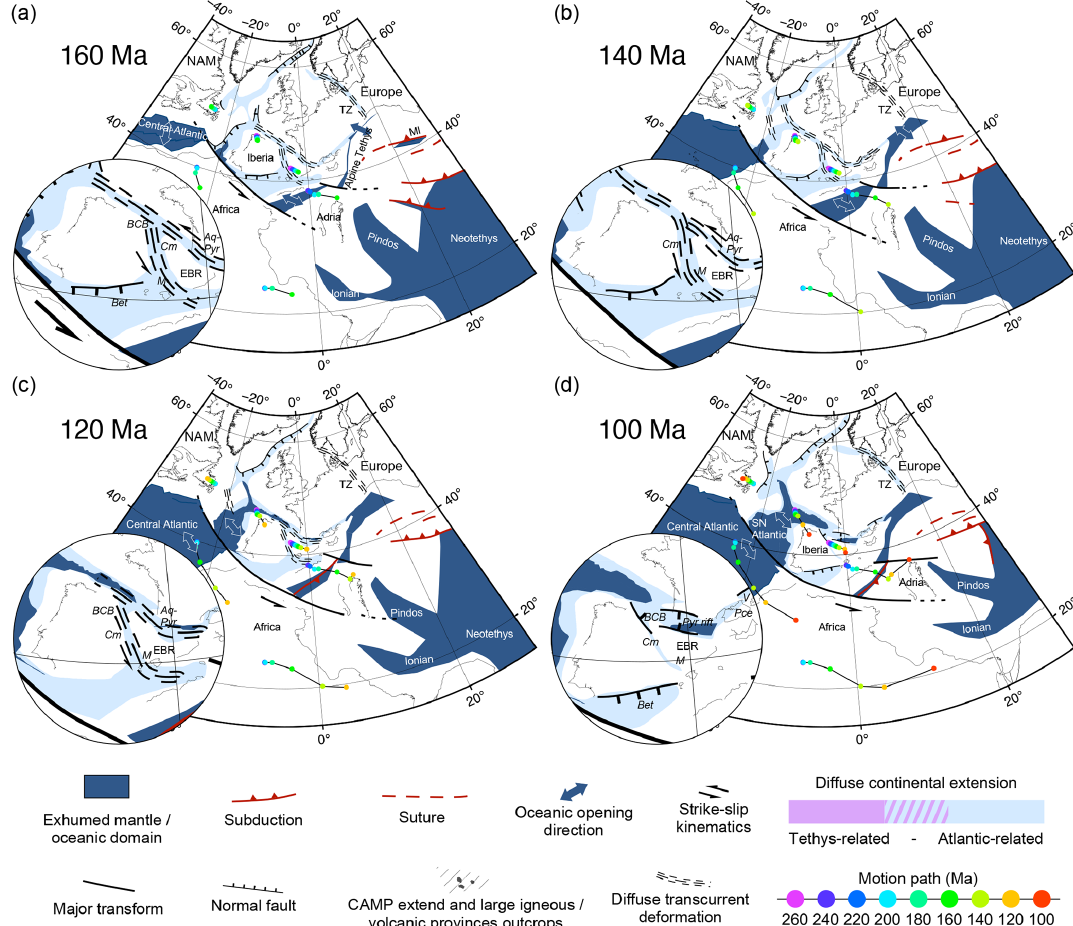
Figure 6. Large-scale reconstruction of the Tethys–Atlantic area for the 160Ma (a) , 140Ma (b) , 120Ma (c) , and 100Ma (d) periods. Maps are in orthographic projection. Closeup shows the evolution of the Iberian plate and the Ebro continental block. Colored background shows diffuse or ill-defined deformation (extension or transtension) in the continents, associated with the evolution of the Tethys (Paleo- and Neotethys, purple) or the Atlantic (blue). Aq-Pyr: Aquitaine–Pyrenean Basin; BCB: Basque–Cantabrian Basin; Bet: Betics Basin; Cm: Cameros; EBR: Ebro; M: Maestrat; Ml: Meliata; Pce: Provence Basin; V: Valaisan Basin; TZ: Tornquist